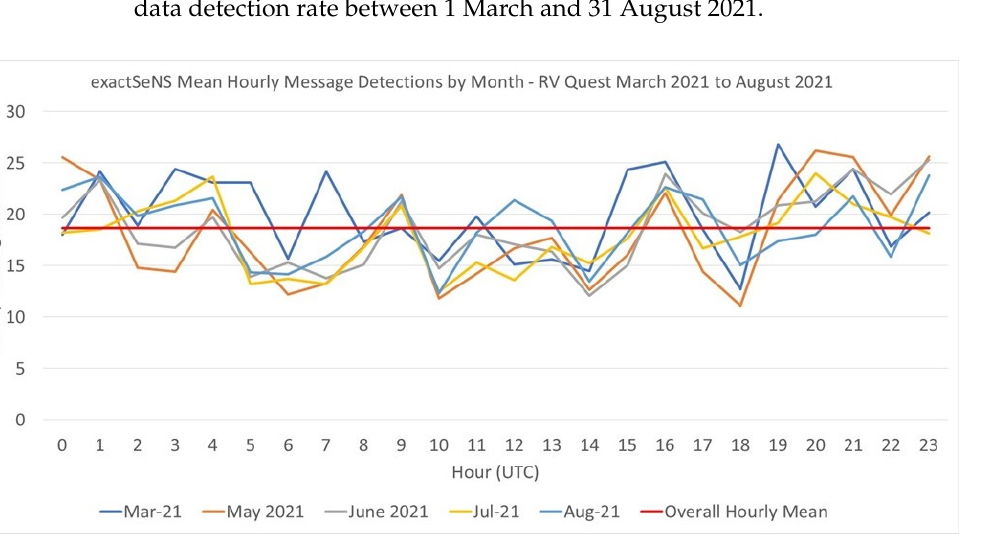
Figure 13. Summary exactSeNS detected hourly message count by month—RV Plymouth Quest extended trial 1 March–31 August 2021. NB: unit not operational in April 2021. extended trial 1 March–31 August 2021. NB: unit not operational in April